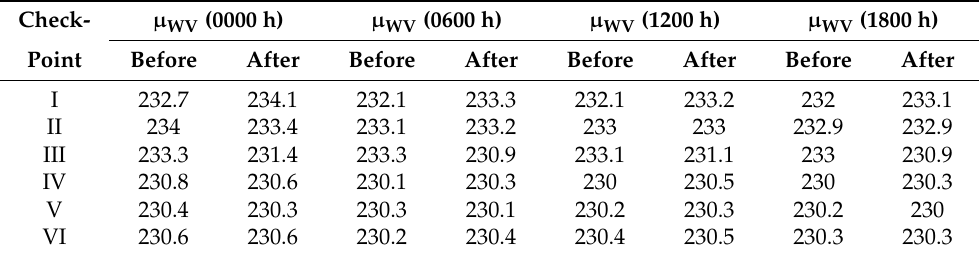
Table 5. WV channel mean BT values (K) before and after the checkpoints.